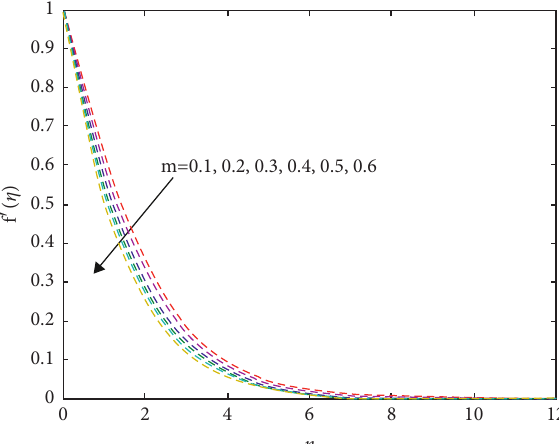
Figure 1: Profiles of f ′ ( η ) for the case of prescribed heat at c � 0 . 5.